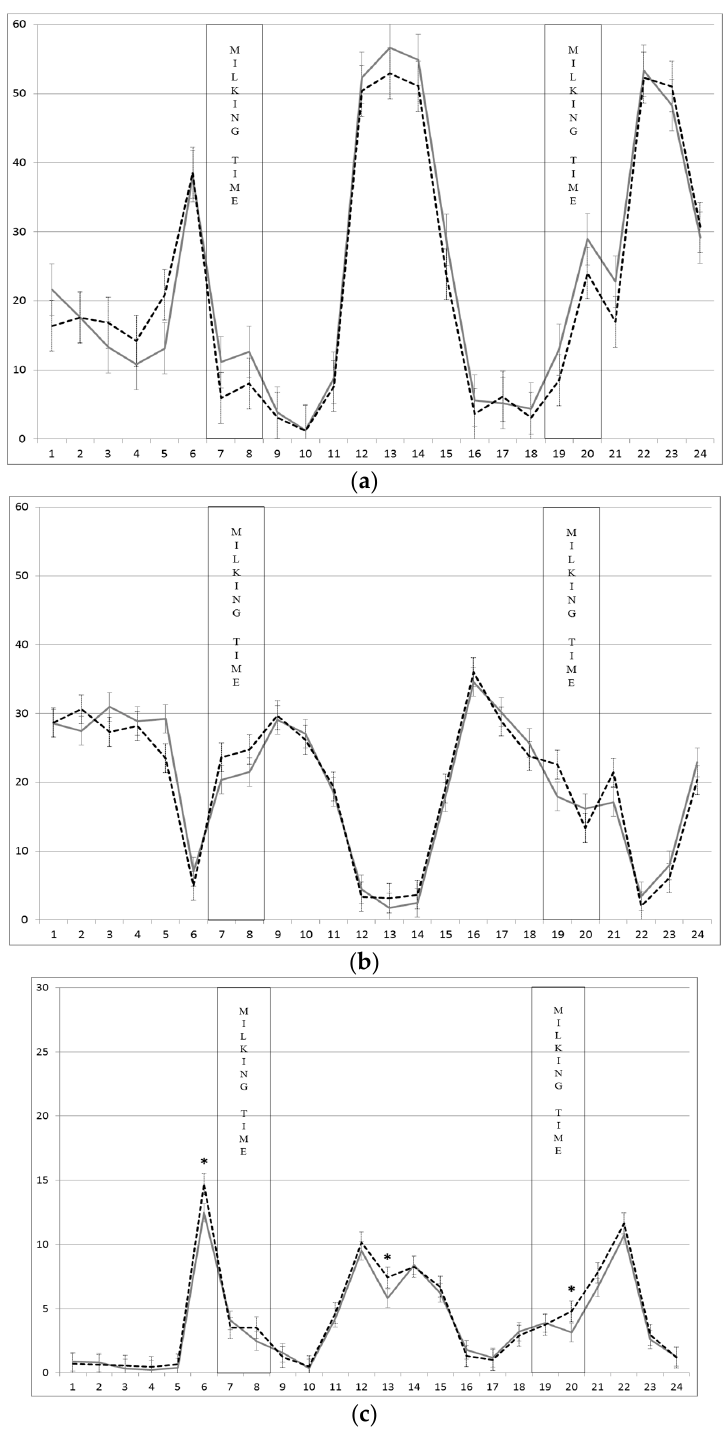
Figure 2. Mean ± SEM of ( a ) grazing time, ( b ) rumination time, ( c ) walking time (min/h) of dairy cows on Poion pasture supplemented with two levels of concentrates (High: solid line and Low: dotted line). The vertical bands represent the milking time of the whole herd. * p < 0.05.